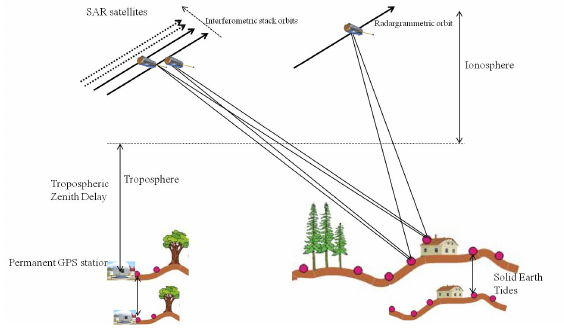
Figure 1: SAR acquisition geometry and slant-range